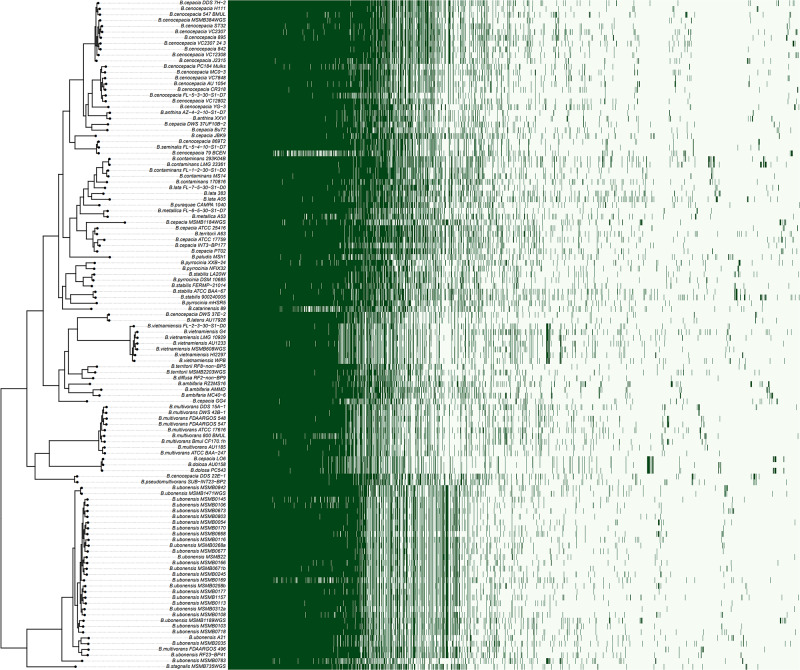
The species tree of Bcc against the genes presence/absence matrix. The species tree was constructed using STAG algorithm and rooted by STRIDE algorithm in OrthoFinder (Emms and Kelly, 2019). The heatmap on the right showed the presence (dark green) or absence (light green) of all 17,740 orthogroups. Each row in the matrix corresponds to a branch on the tree (i.e., one genome) and each column represented an orthogroup.